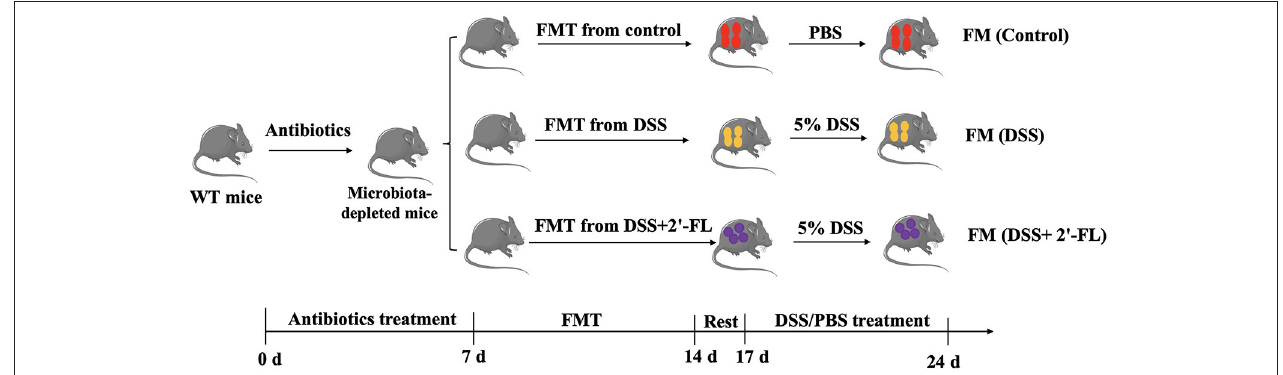
FIGURE 2 | Experimental workflow of fecal microbiota transplantation